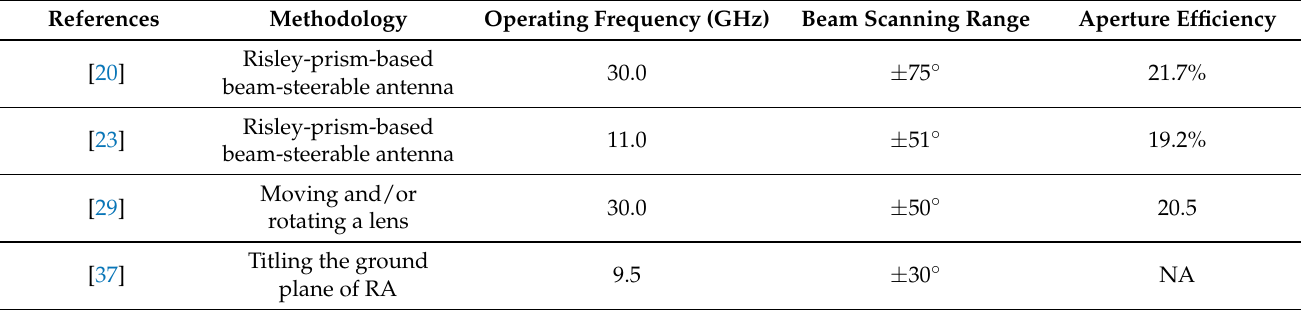
Figure 7. Illustrative typologies of mechanical beam-steerable reflectarray by moving/tilting the ground plane. ( a ) Reflectarray topology with tilting the single ground plane. ( b ) Piezoelectric actuators implemented prototype. ( c ) Topology of the reflectarray with a segmented ground plane. (Reprinted with permission from [37]). Table 2. Comparative analysis of mechanically reconfigurable beam-steerable antennas using array movement